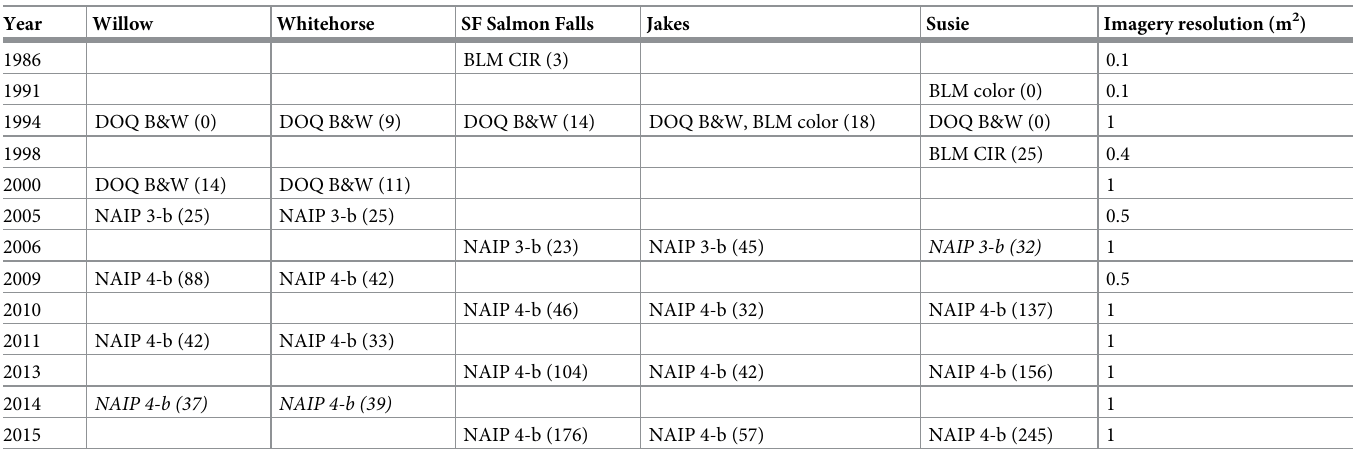
Table 2. Imagery used to identify beaver